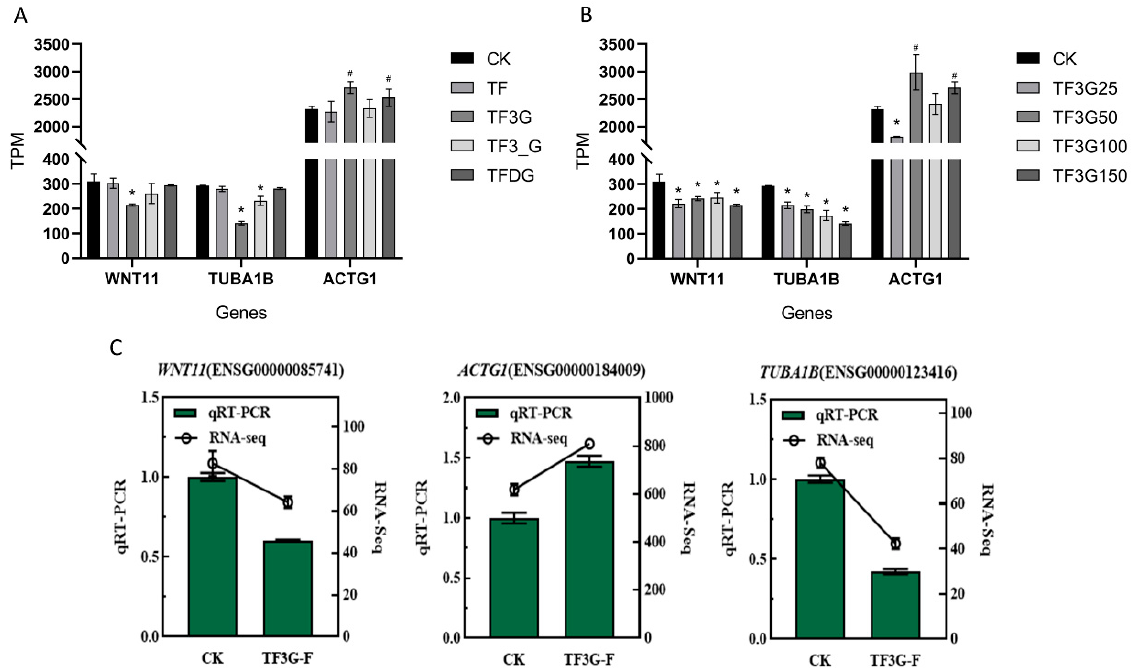
Figure 7. ( A ) Expression of key DEGs under different TFs treatments. ( B ) Expression of key DEGs under the treatment of different concentrations of TF3G. ( C ) qRT-PCR analysis of key DEGs between TF3G and CK groups. * , significant decrease relative to CK at p < 0.05; # significant increase relative to CK at p < 0.05.